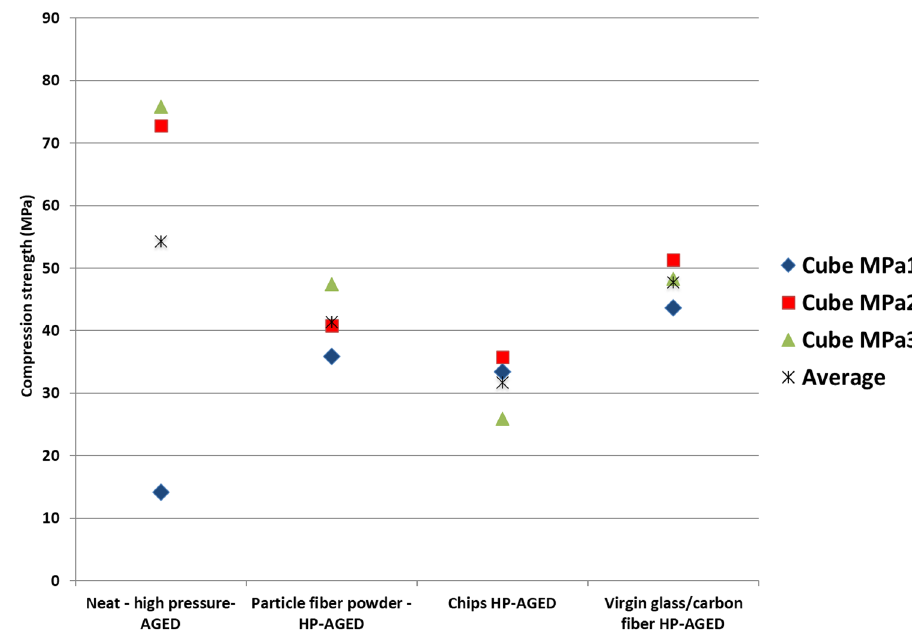
Fig. 12 Compression strengths of the high-pressure com- pacted cement with and without PFP admixtures after salt-aging for 30